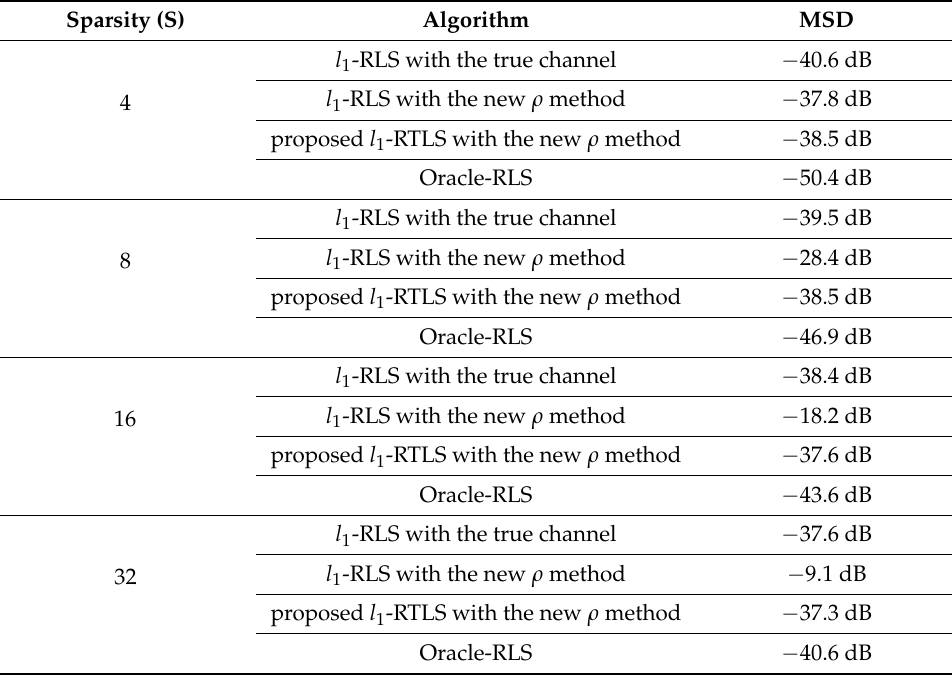
Table 2. MSD (mean square deviation) comparison.